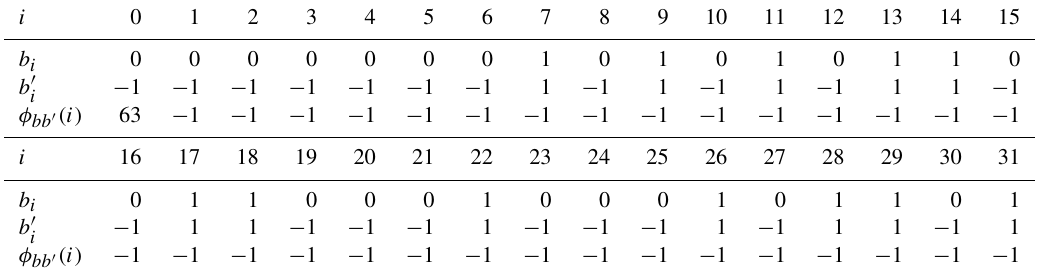
Table 1. Sequences of residual light code, its associated receiving code, and their correlation for N = 31.